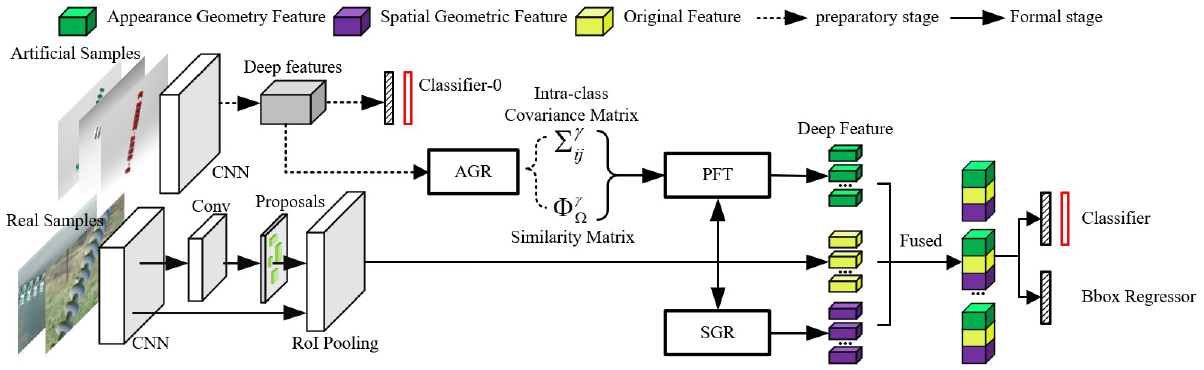
Figure 2. Architecture of the proposed MGRN. In the preparatory phase, the appearance geometric features of the artificial samples are modelled as intra-class covariance matrices and similarity matrices by the AGR sub-module. In the formal phase, the original features are extracted from the real samples (using CNN and RoI Pooling); the appearance geometric and spatial geometric features are extracted from the real samples (using SGR sub-module and PFT sub-module); finally the obtained features are fused from the real